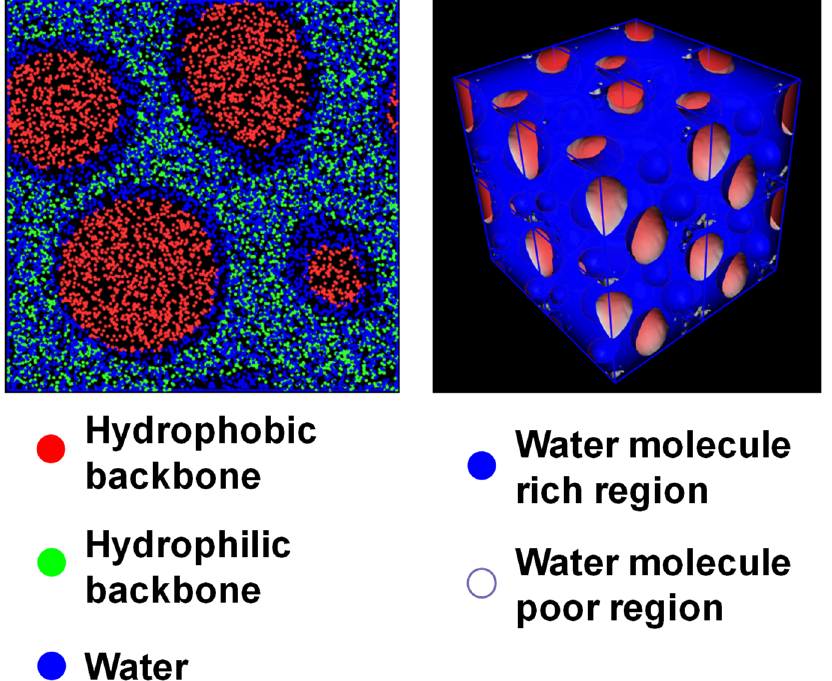
Figure 4. Sliced and 3D images of the mesoscale results of the modified SD model at 298 K after 10,000 steps.